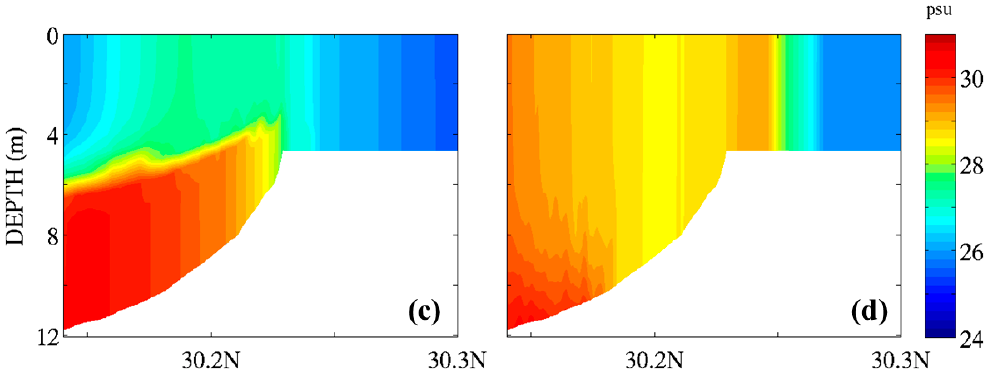
Figure 14. Model results, salinity. ( a ) Surface salinity at 1600 UTC on 4 / 4. Vertical black line indicates location of the vertical sections shown in panels c and d ; ( b ) Surface salinity at 1600 UTC on 4 / 5; ( c ) Vertical salinity corresponding to date / time indicated in panel a ; ( d ) Vertical salinity corresponding to date / time indicated in panel b .